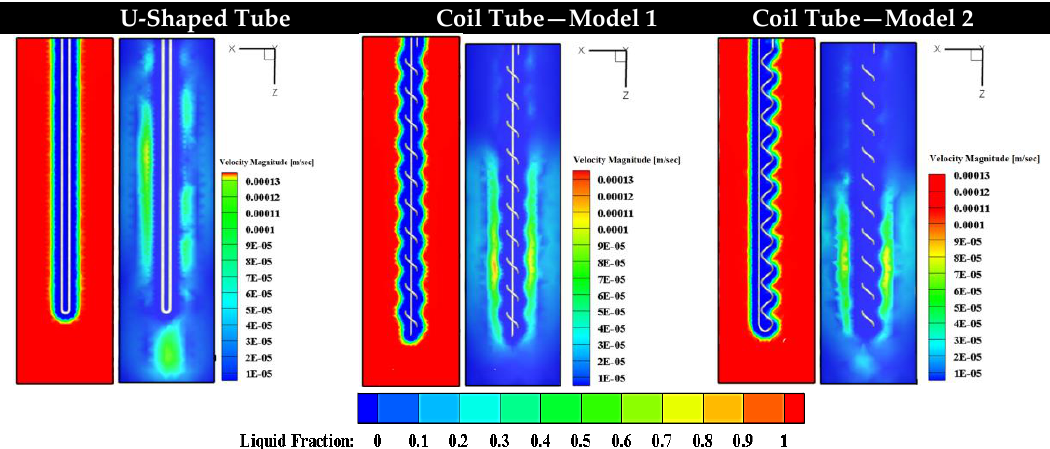
Figure 11. Temporal evolution of the liquid fraction for three types of tubes in the ice on coil ice storage system in the vertical position.